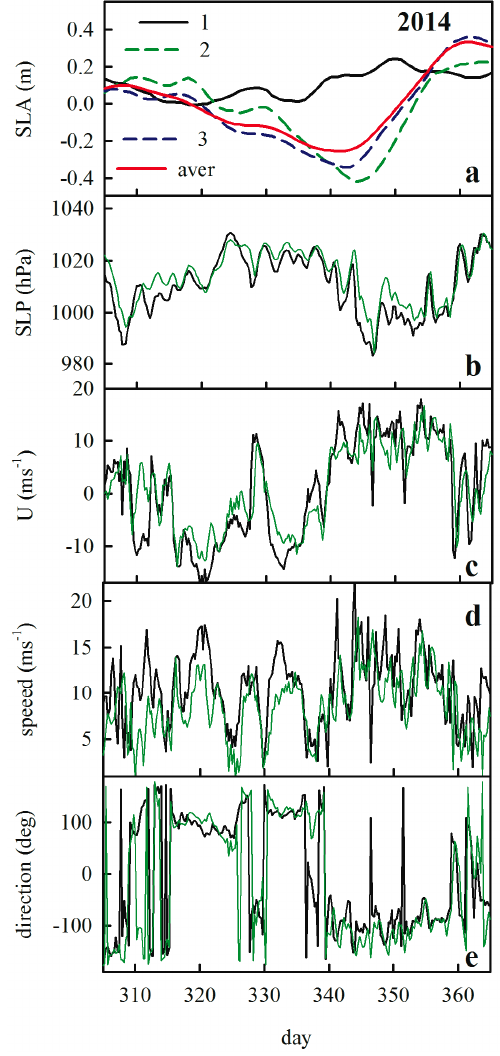
Figure 2. Time series of ( a ) SLA at pixels 1–3 and SLA averaged over the area indicated in Figure 1. ( b ) The sea level pressure (SLP) at locations 1 and 2. ( c ) The U component of wind at locations 1 and 2. ( d ) The wind speed at locations 1 and 2. ( e ) The wind direction at locations 1 and 2. Data are presented for MBI in 2014.